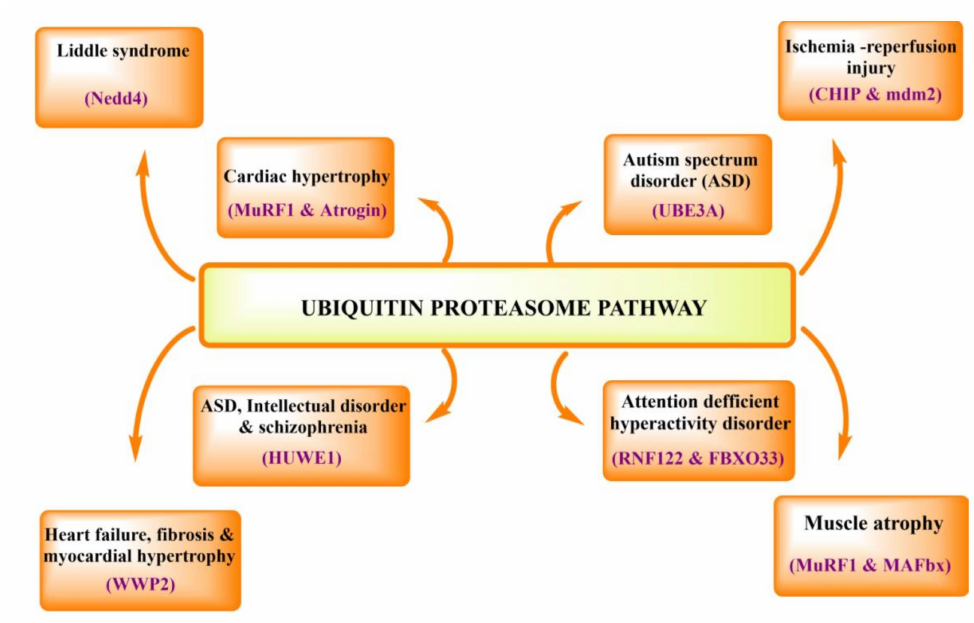
Figure 7. This figure represents the UPP and their respective enzymes i.e., Nedd4, MuRF1& Atrogin, UBE3A, CHIP & mdm2, HUWE1, RNF122 & FBXO33, WWWP2, MuRF1 & MAFbx IN Different